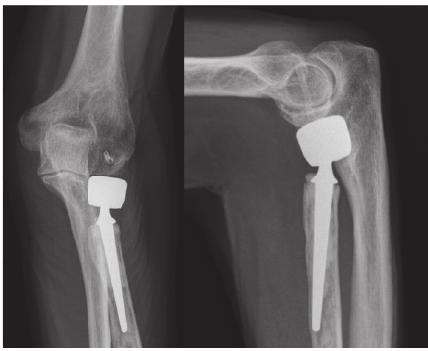
Figure 4: At one-year follow-up, the patient showed an excellent clinical result. The contour of the MAGNEZIX CS implant is still clearly